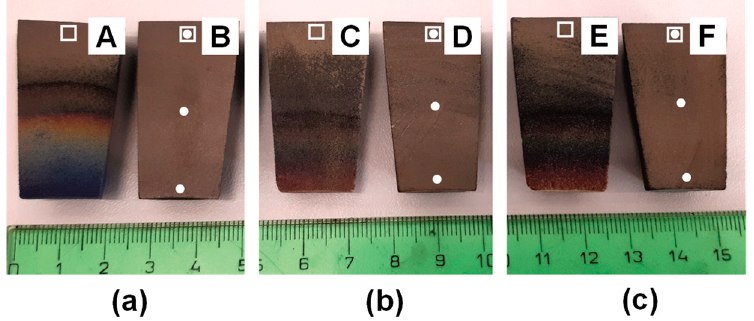
Figure 2. Macrostructure of oxidized samples: ( a ) Ni; ( b ) Ni with Al 2 O 3 particles with a diameter of 5–20 µ m; ( c ) Ni with Al 2 O 3 particles with a diameter of 32–45 µ m. A, C, E after the first oxidation cycle; B, D, F after the second oxidation cycle. The open white squares indicate regions from which SEM images were taken. The white dots represent regions where SEM, EDS, and XRD analyses were performed.